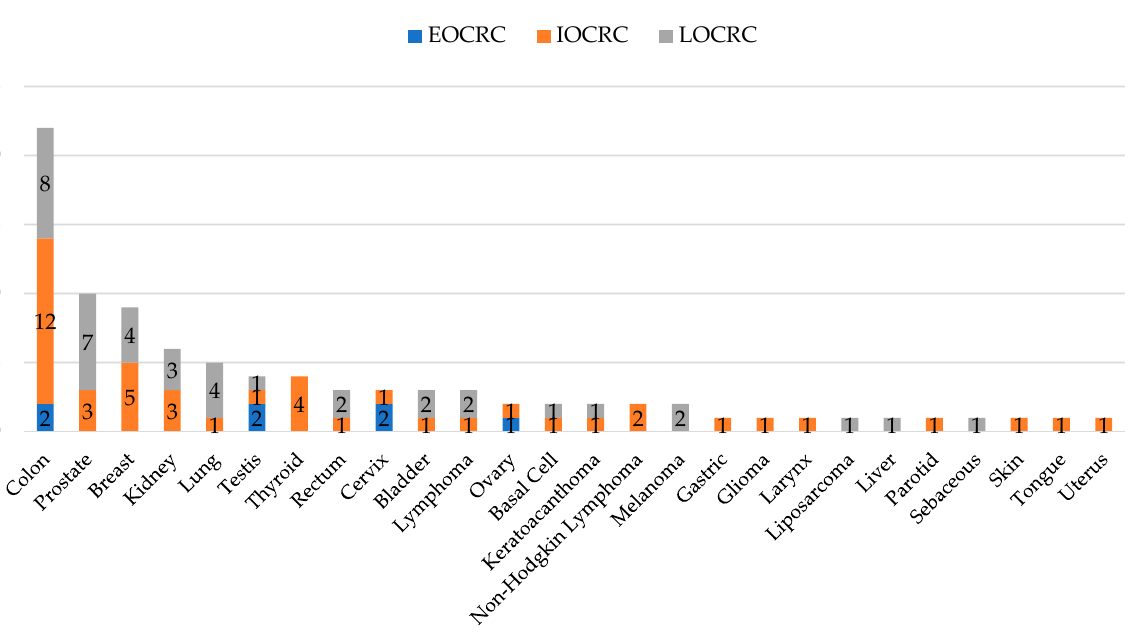
Figure 1. Personal history of other synchronous or metachronous malignant tumors: Tumor type frequency according to the age of onset.